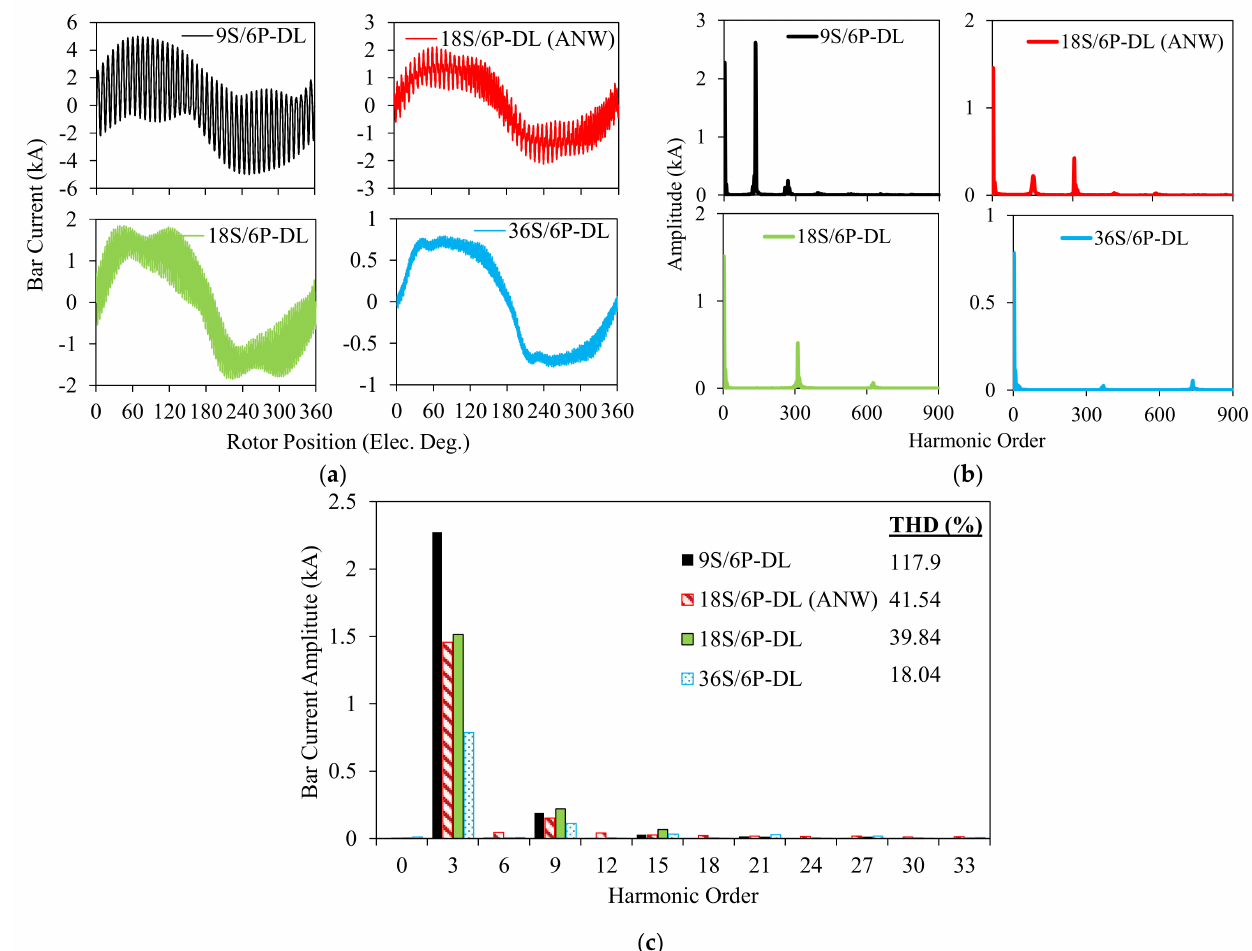
Figure 17. Rotor bar current: ( a ) waveforms, ( b ) harmonic spectra, and ( c ) low-order harmonics. Even if the 9S/6P IM has the highest N p , due to the increased saturation level of the stator teeth (see Figure 18), the magnitude of the air gap flux density is lower than those of other IMs, as seen in Figure 16b. On the other hand, since the space harmonic index of 36S/6P is the lowest, the distortion level of maximum and minimum for the bar current waveforms of 9S/6P FSCW and 36S/6P ISDW can be predicted, respectively. This is